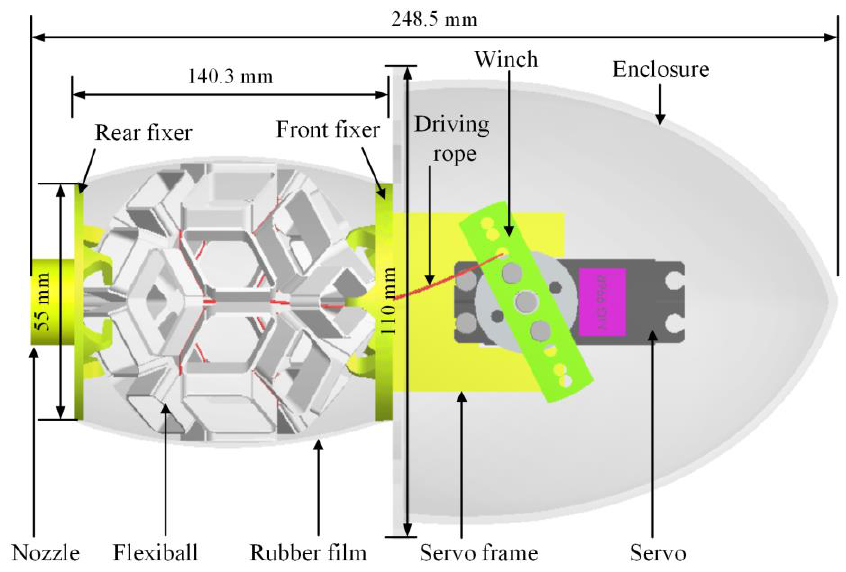
Figure 15. Overall structure of origami flexiball inspired bionic jellyfish robot.